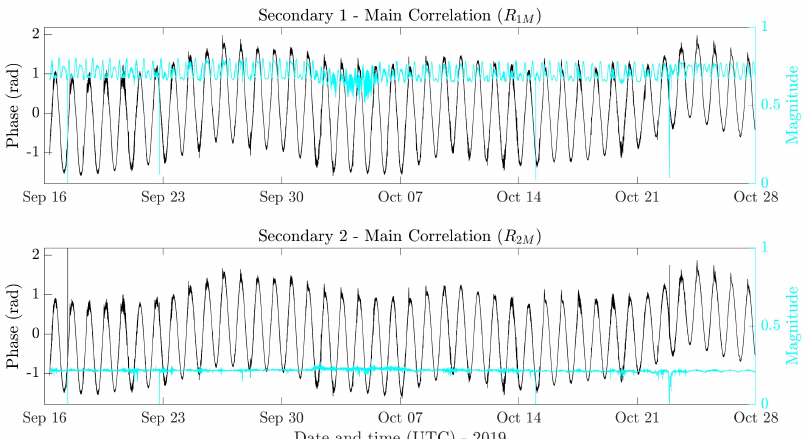
Figure 5. September–October 2019. Interferometric phase measurements corresponding to the As- tra 1M satellite transmitting DVB-S TV broadcasting signals from a 19.2 ◦ E longitude station. Despite the magnitude of the correlation dropping dramatically due to the SNR degradation, the quality of the phase information remains unaltered (RMSD 0.18 rad). This demonstrates the robustness of the system, allowing it to work with weak